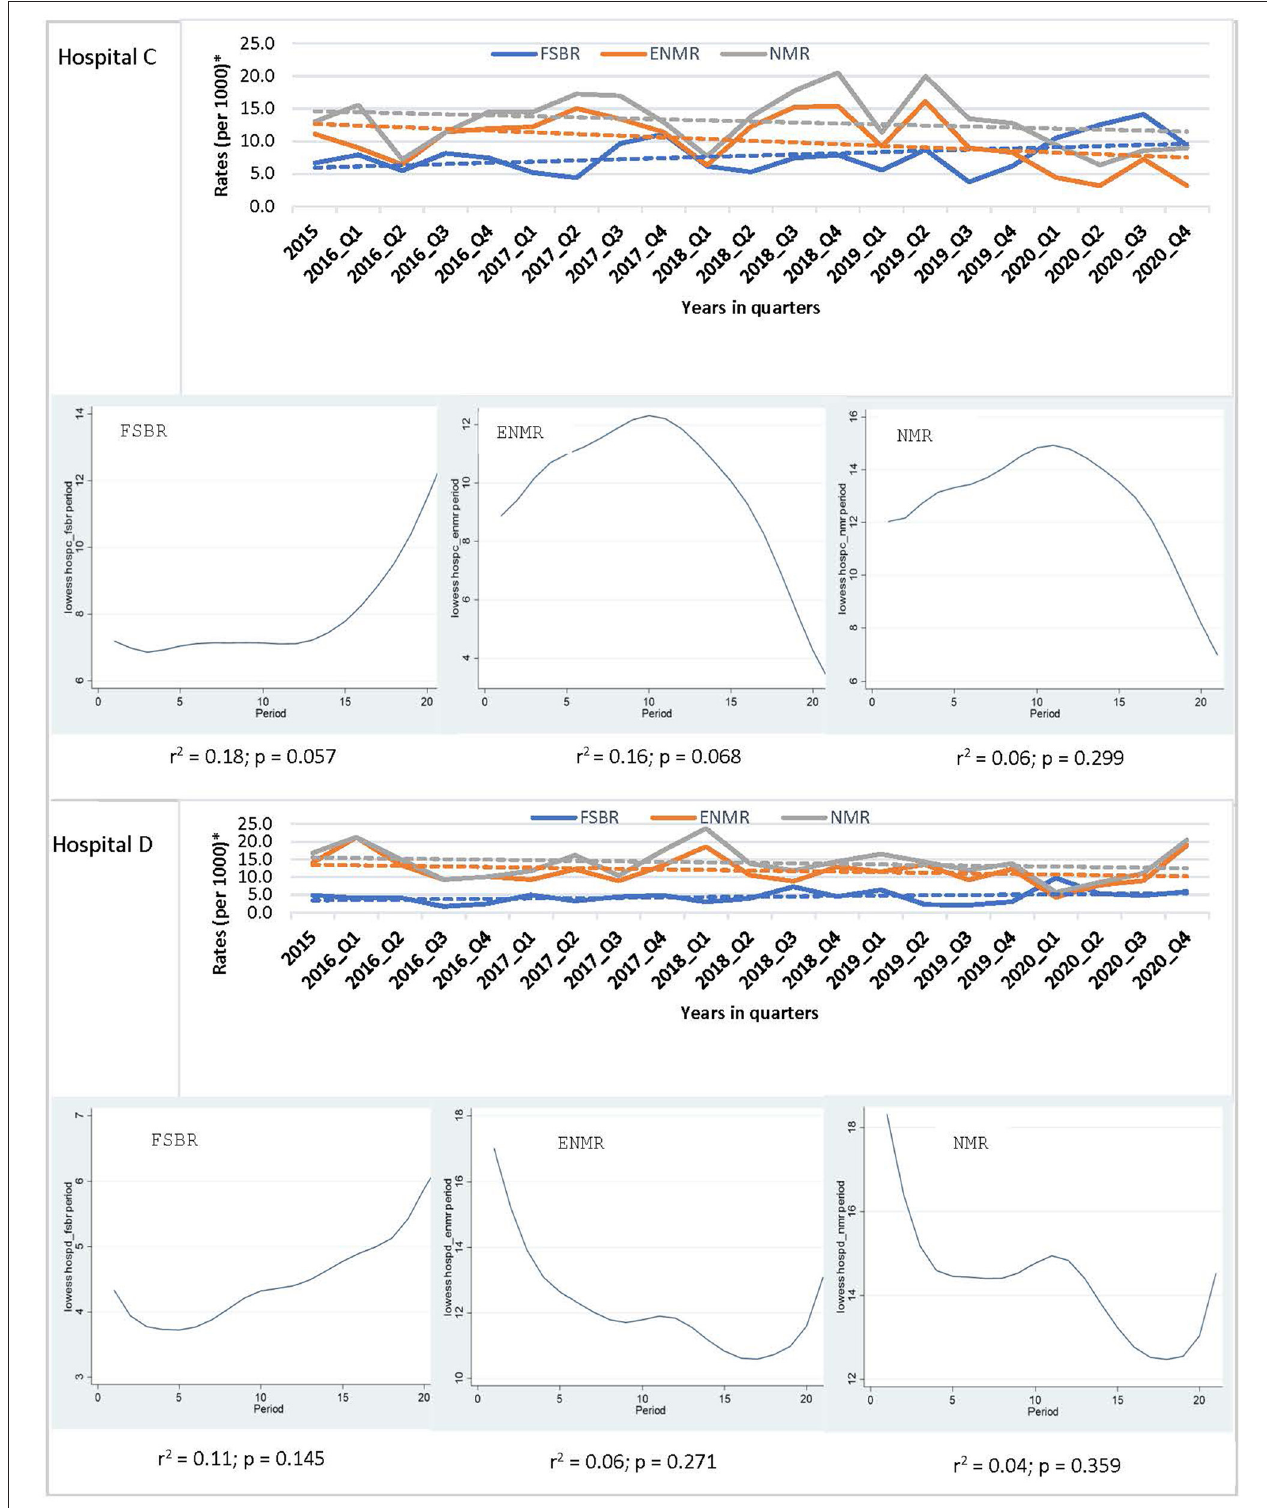
FIGURE 4 | Trends in fresh stillbirth rate (FSBR), early neonatal mortality rate (ENMR), and neonatal mortality rate (NMR), with locally weighted scatterplot smoothing (LOWESS) regression analysis in the lower panel of the Figure for regional hospitals (Hospitals C and D). * Per 1,000 total births for fresh stillbirth rates (FSBR) and per 1,000 live births for early neonatal mortality rate (ENMR) and neonatal mortality rate (NMR).